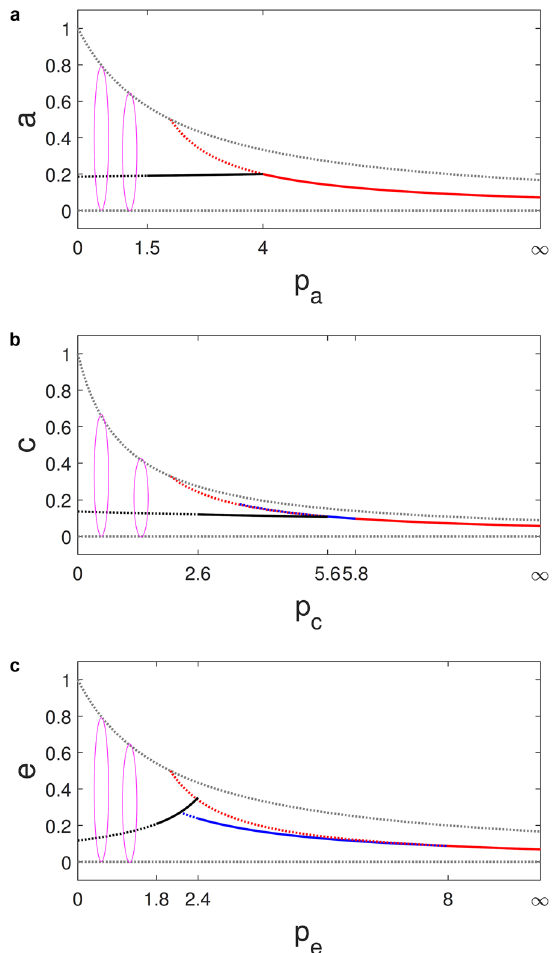
Figure 3. Bifurcation with intraspecific parameter. Solid lines and ellipses indicate stable fixed points and heteroclinic cycles, respectively, and dots are for unstable fixed points. Different fixed points are distinguished by colors. ( a ) For the RPS game, the survival states of three and two species (black and red lines), respectively. ( b ) For the ERPS game, black, blue and red lines indicate the survival states of five, four, and three species, respectively. ( c ) For the RPSLS game, black, blue and red lines specify the survival states of five, four and three species,